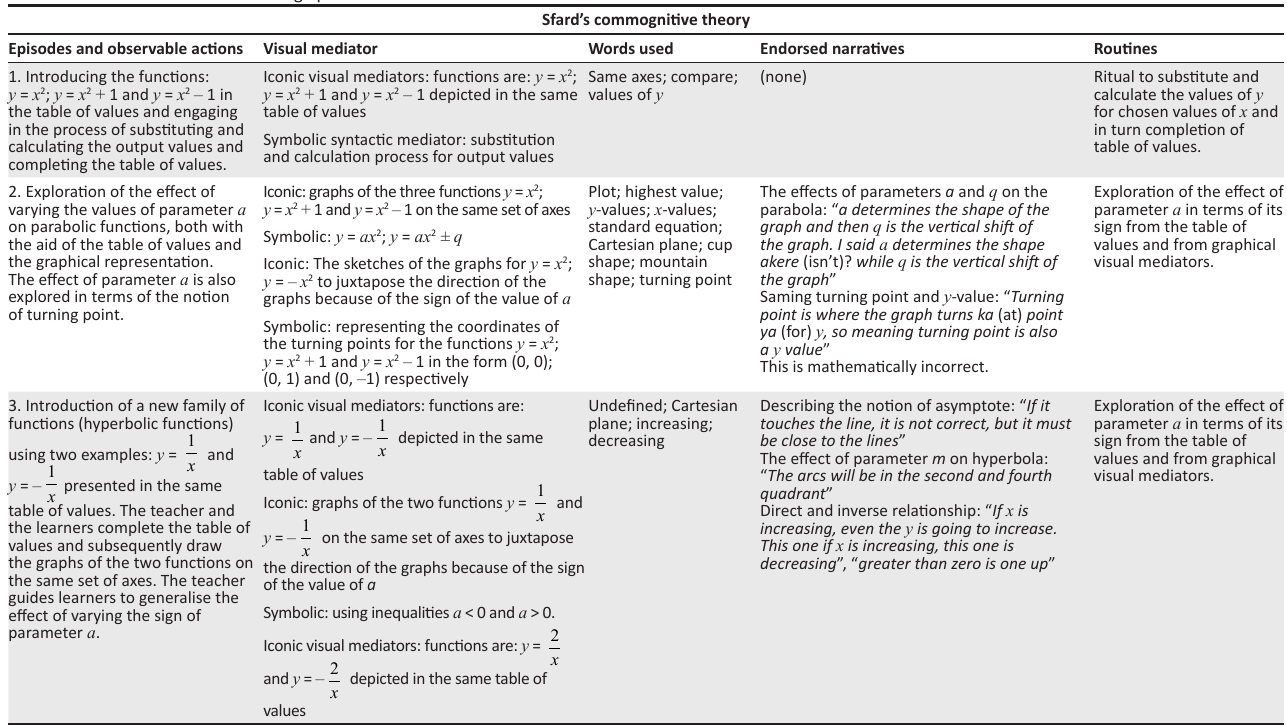
TABLE 5: Discourses in Zelda’s teaching episodes.